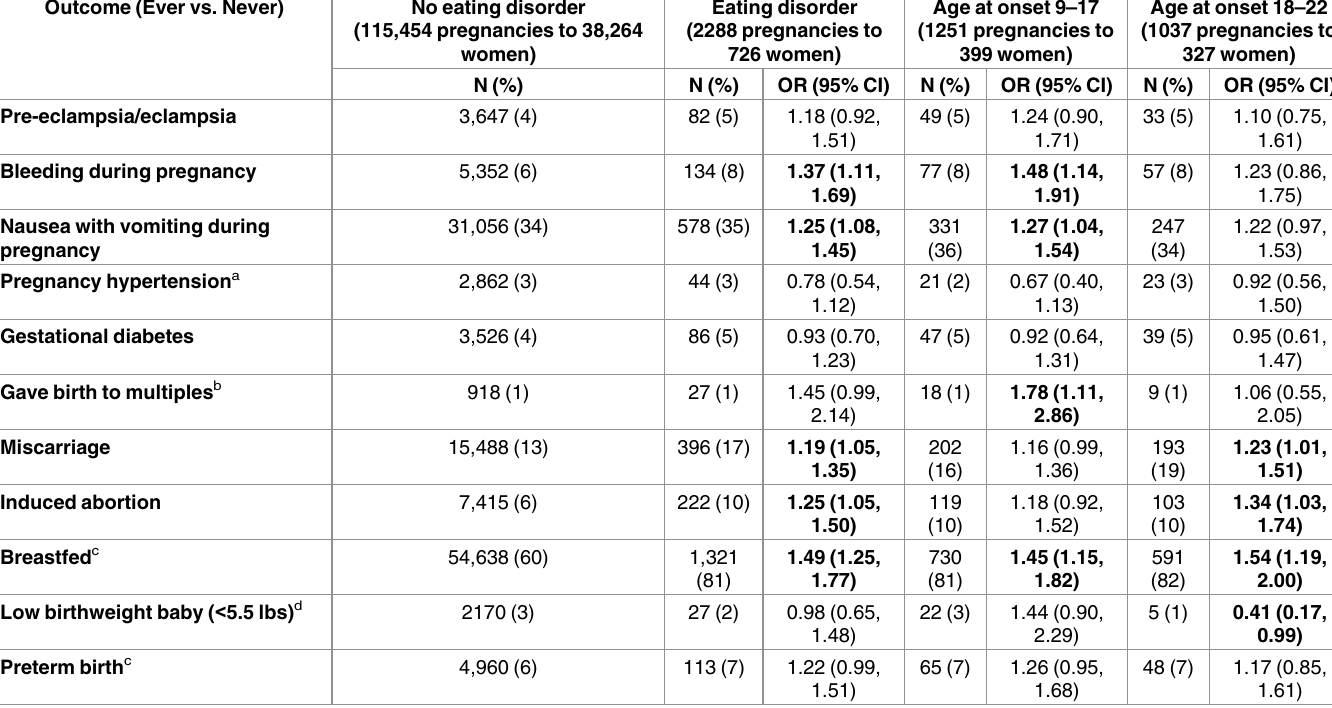
Table 4. Odds ratios (ORs) and 95% confidence intervals (CIs) for the association between eating disorder status and birth-related outcomes in parous women (n = 38,990). Outcome (Ever vs.